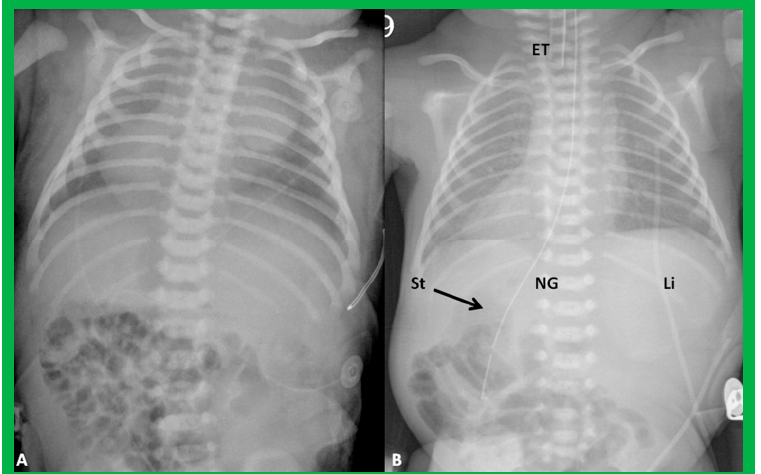
Figure 2. Chest X-rays of two different newborn babies with hearts situated in the right chest, i.e., dextrocardia. ( A ) The liver (Li) is visualized across the abdominal cavity without seeing the stomach air bubble; thus, it is not possible to establish the visceral situs. ( B ) On the other hand, the stomach (St) air shadow is faintly seen on the right side of the abdomen while the Li is imaged on the left side. The findings in ( B ) indicate inversion of the visceral position, situs inversus. Furthermore, the location of the St on the right is established by the location of the NG (nasogastric) tube. Air in the intestine is seen in the lower portion of the abdomen in both infants. ET, endotracheal tube. Reproduced from reference [4].